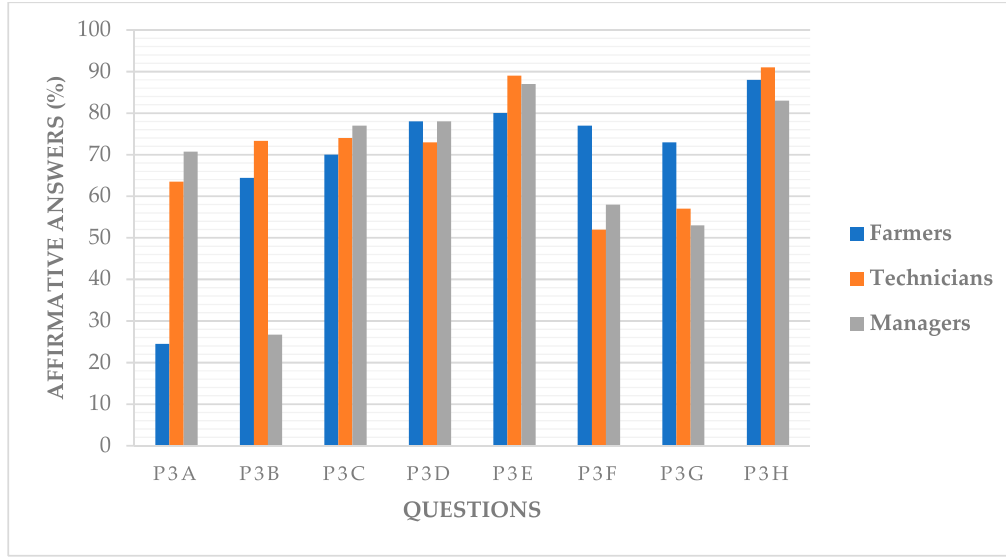
Figure 6. Answers for questions in Block 2 (all groups).